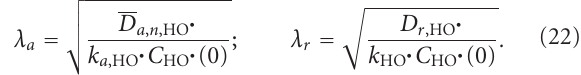
Figure 1: Scheme of anode with the adjacent layers of the solution (not in